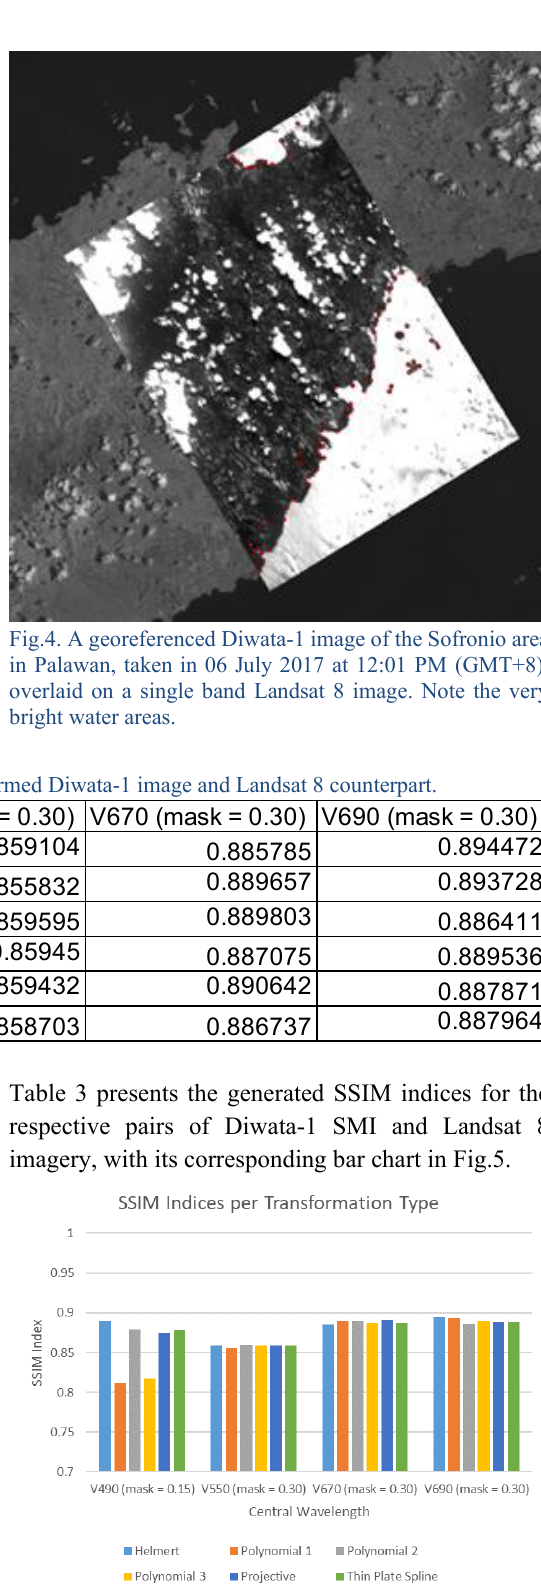
Fig.5. A bar chart representation of the values in Table 3.